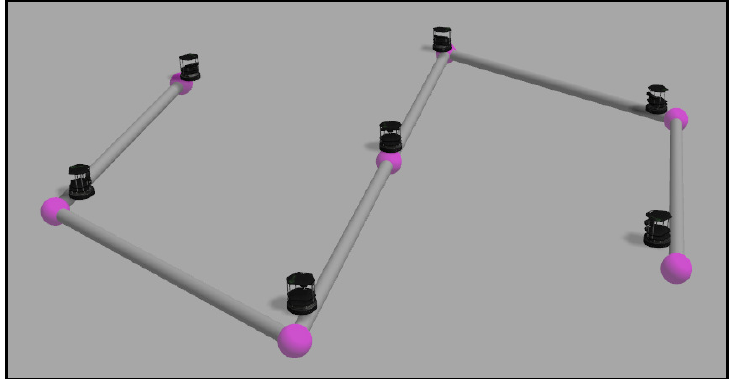
Figure 15. Final layout in an expansion without